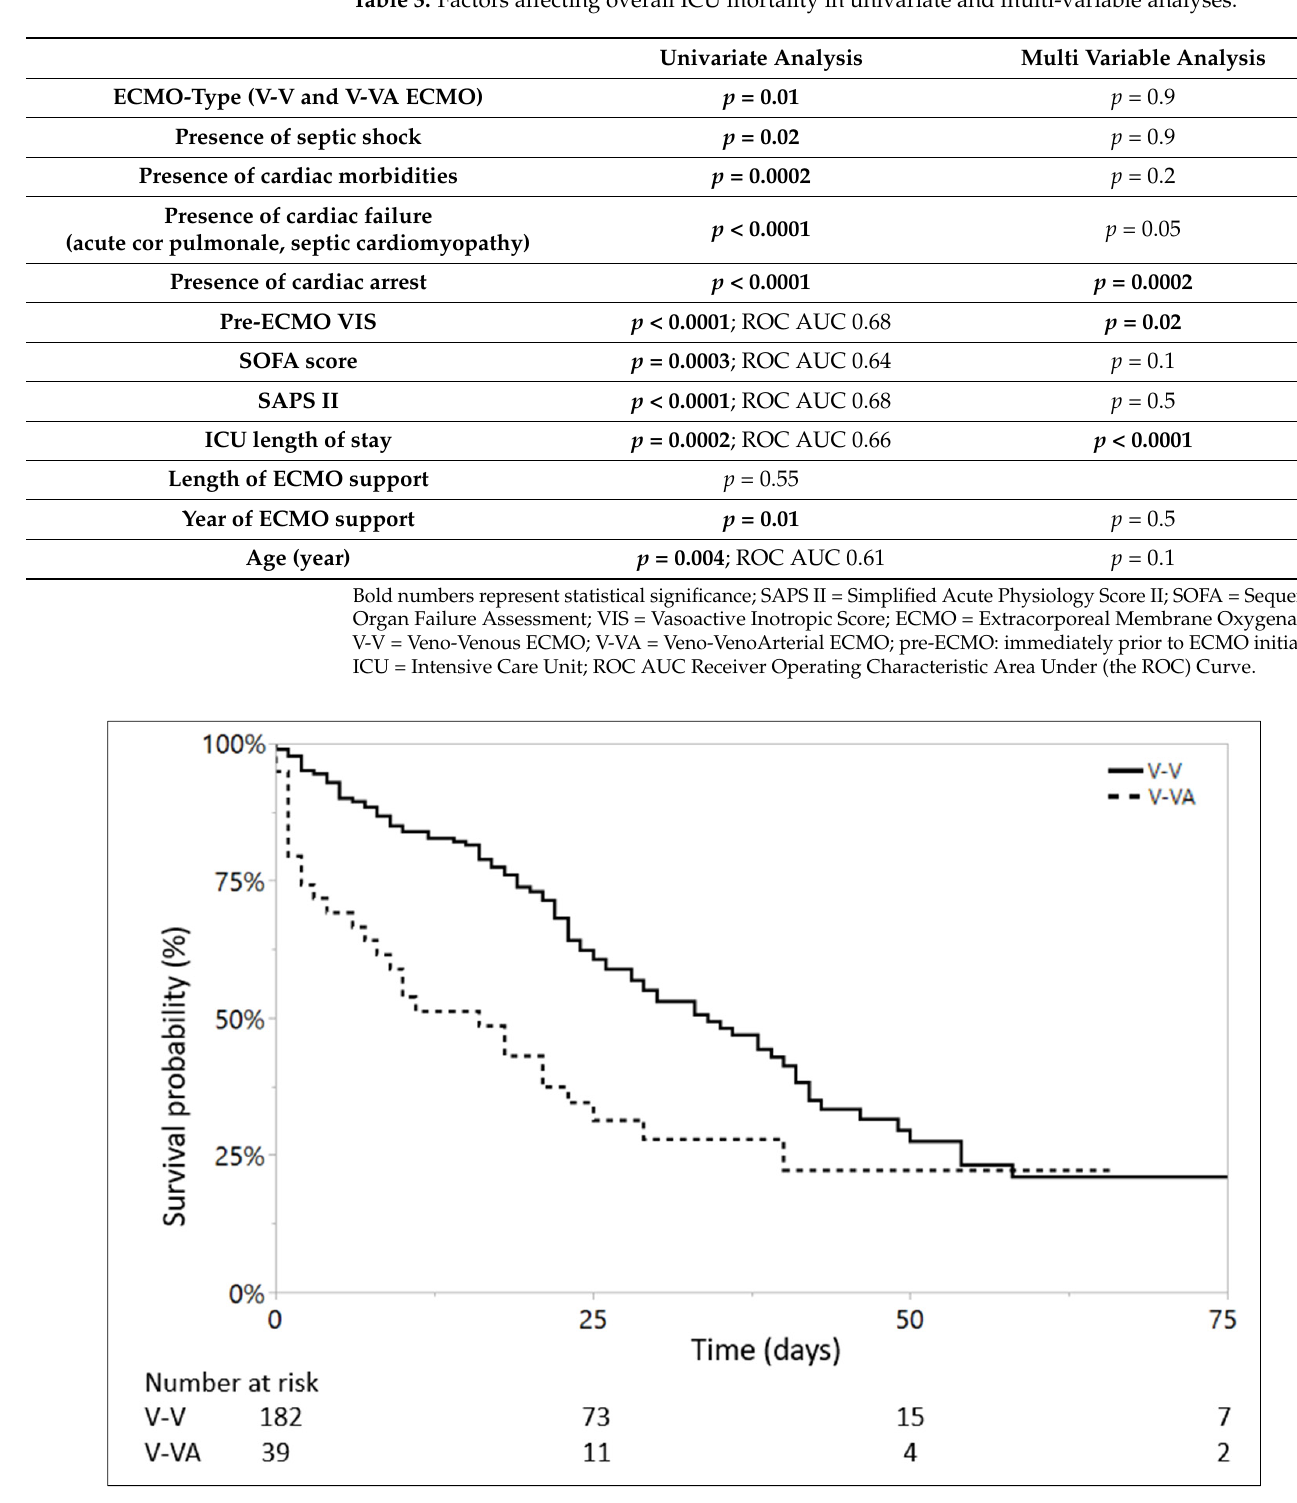
Figure 2. Kaplan–Meier curve for V-V and V-VA ECMO groups, Log-Rank p = 0.002. ECMO = Extracorporeal Membrane Oxygenation; V-V = Veno-Venous ECMO; V-VA = Veno-VenoArterial ECMO.